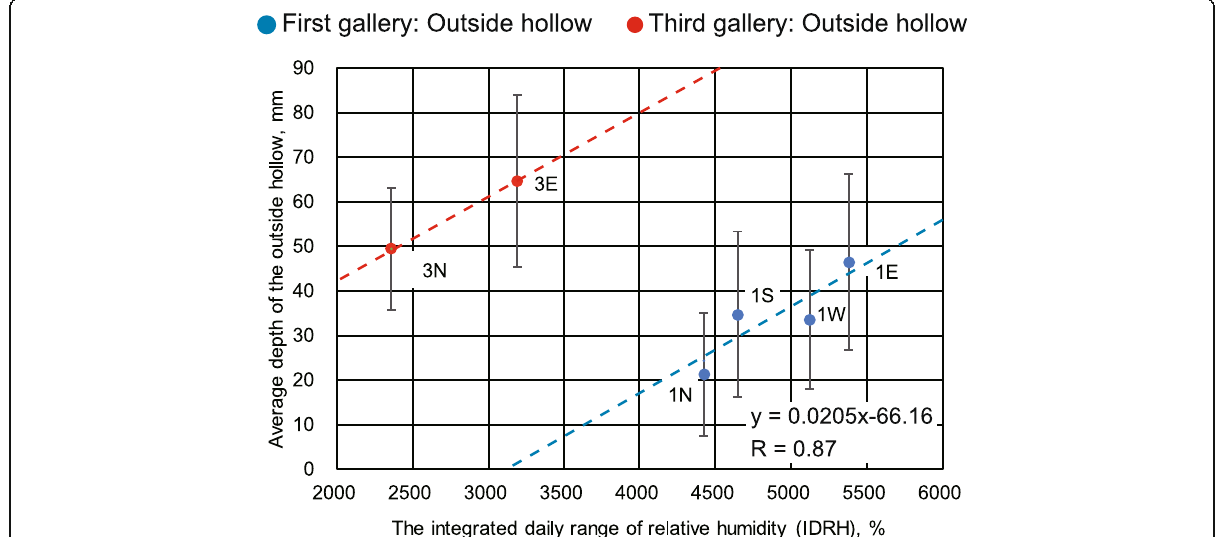
Fig. 10 Relationships between the average depth of the outside hollow and the integrated daily range of relative humidity (IDRH) of the galleries. A blue dashed line accompanied with an equation and correlation coefficient ( R ) indicates a regression line of the first gallery. A red dashed line indicates a trend line of the third gallery. Bars indicate the standard deviation of the hollow